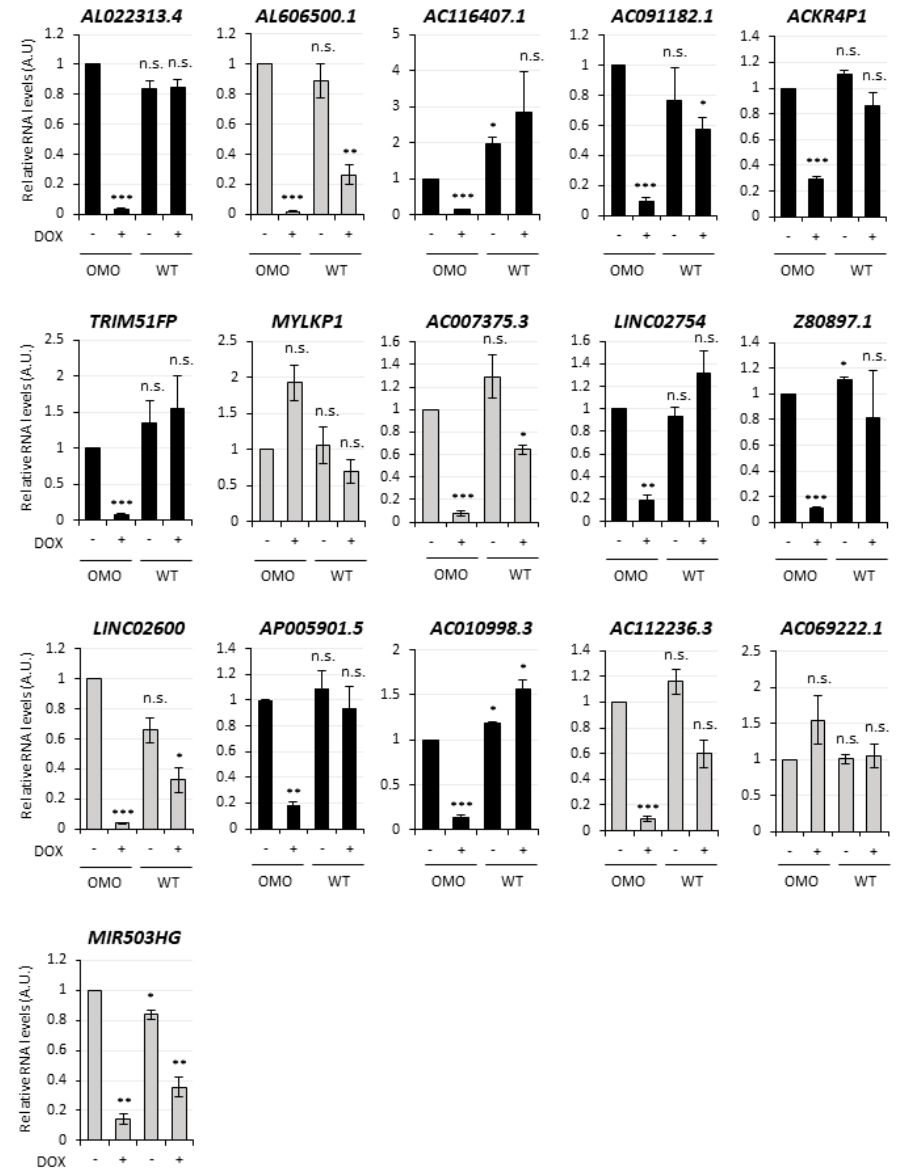
Figure 3. Validation of the MYC-dependent lncRNAs downregulated by OMOMYC in D283 MED cells. qRT-PCR analysis in D283-OMO cells 72 h-treated with DOX (OMO+) of the most expressed and downregulated lncRNAs, according to the RNA-Seq. Among the 20 top hits from the Dataset S3 16 RNAs were successfully detected included in the figure. Expression levels were compared to untreated D283-OMO (OMO − ) as control, set as 1. Parallel analysis in untreated (WT − ) vs. treated WT (WT+) D283 MED cells revealed possible unspecific effects of DOX on lncRNA expression. Validated candidates (9 lncRNAs) are indicated by black histograms, non-validated candidates (7 lncRNAs) are reported in grey. Data (means ± SEM) are expressed in arbitrary units and are relative to ATP5O mRNA levels. N = 3, * p ≤ 0.05, ** p ≤ 0.01, *** p ≤ 0.001 (two- tailed Student’s t -test).